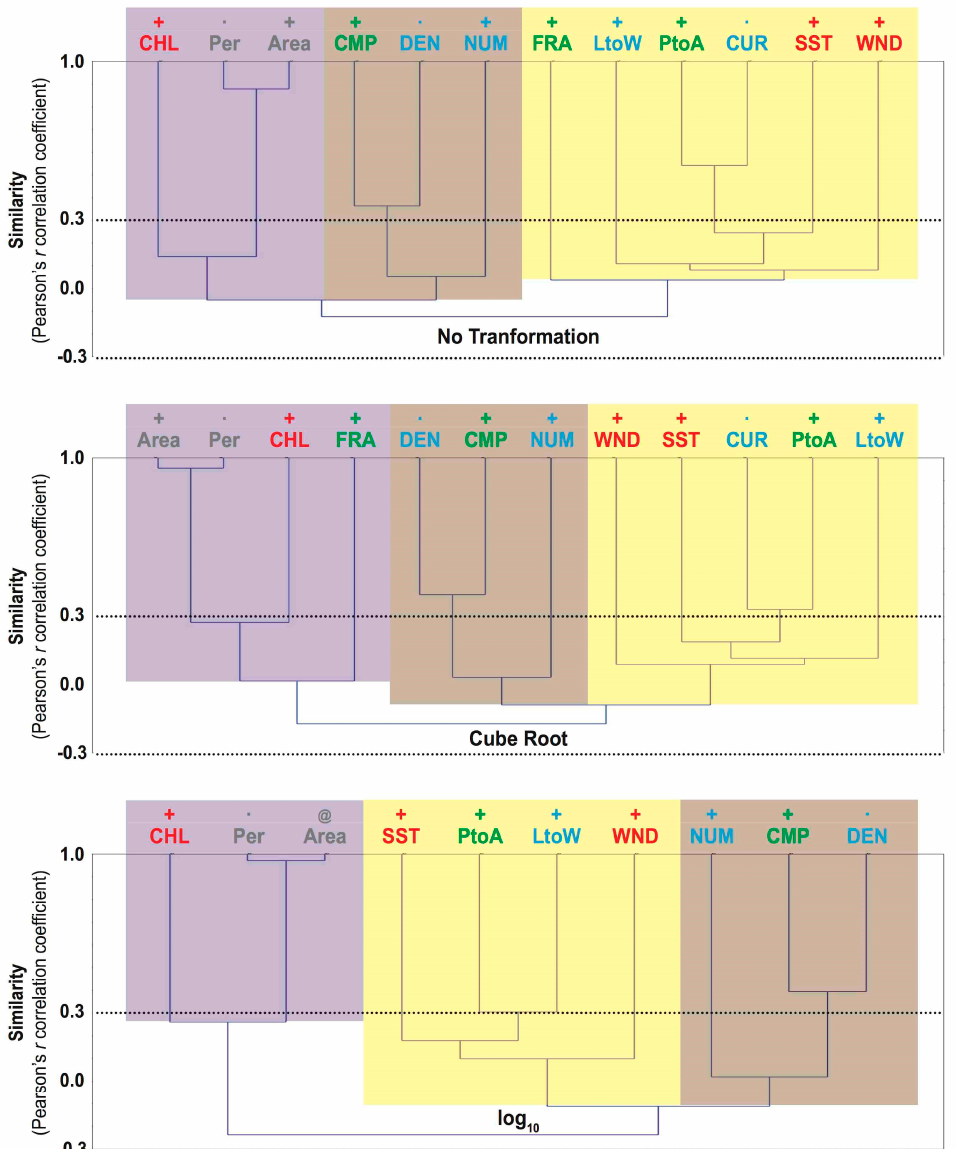
Figure 4. Example of a feature selection process for one attribute–domain subdivision: All size information with meteo-oceanographic (MetOc) variables, see also Table 5. These are dendrograms (Unweighted Pair Group Method with Arithmetic Mean; UPGMA) for the three non-linear transformations: none (top), cube root (middle), and log 10 (bottom). Uncorrelated selected variables (Pearson’s correlation coe ffi cient: 0.3 > r > − 0.3; represented by the dotted phenon lines) both with and without MetOc ( + ) and only with MetOc (@). Variables not selected due to statistical correlation (0.3 < r < − 0.3) are marked with a dot. Explored variables ( n = 12): Area, Per (perimeter), PtoA (perimeter-to-area ratio), CMP (compact index: 4. π .Area / Per 2 ), FRA (fractal index: 2.ln(Per / 4) / ln(Area)), LtoW (length-to-width ratio), DEN (density), CUR (curvature), NUM (number of parts), SST (sea surface temperature), CHL (chlorophyll-a concentration), and WND (wind speed). Gray ( n = 2): Area and Per, refers to Carvalho’s subdivision. Green ( n = 3): PtoA, CMP, and FRA, refer to Carvalho et al.’s subdivision. Blue ( n = 4): LtoW, DEN, CUR, and NUM, refer to Bentz’s subdivision. Red ( n = 3): SST, CHL, and WND magnitudes, refer to MetOc-Only’s subdivision. For more about the origin of the variable subdivisions see Sections 3.2 and 3.3. Visually formed groups of variables are shown as purple, brown, and yellow (see Section 3.3.1).